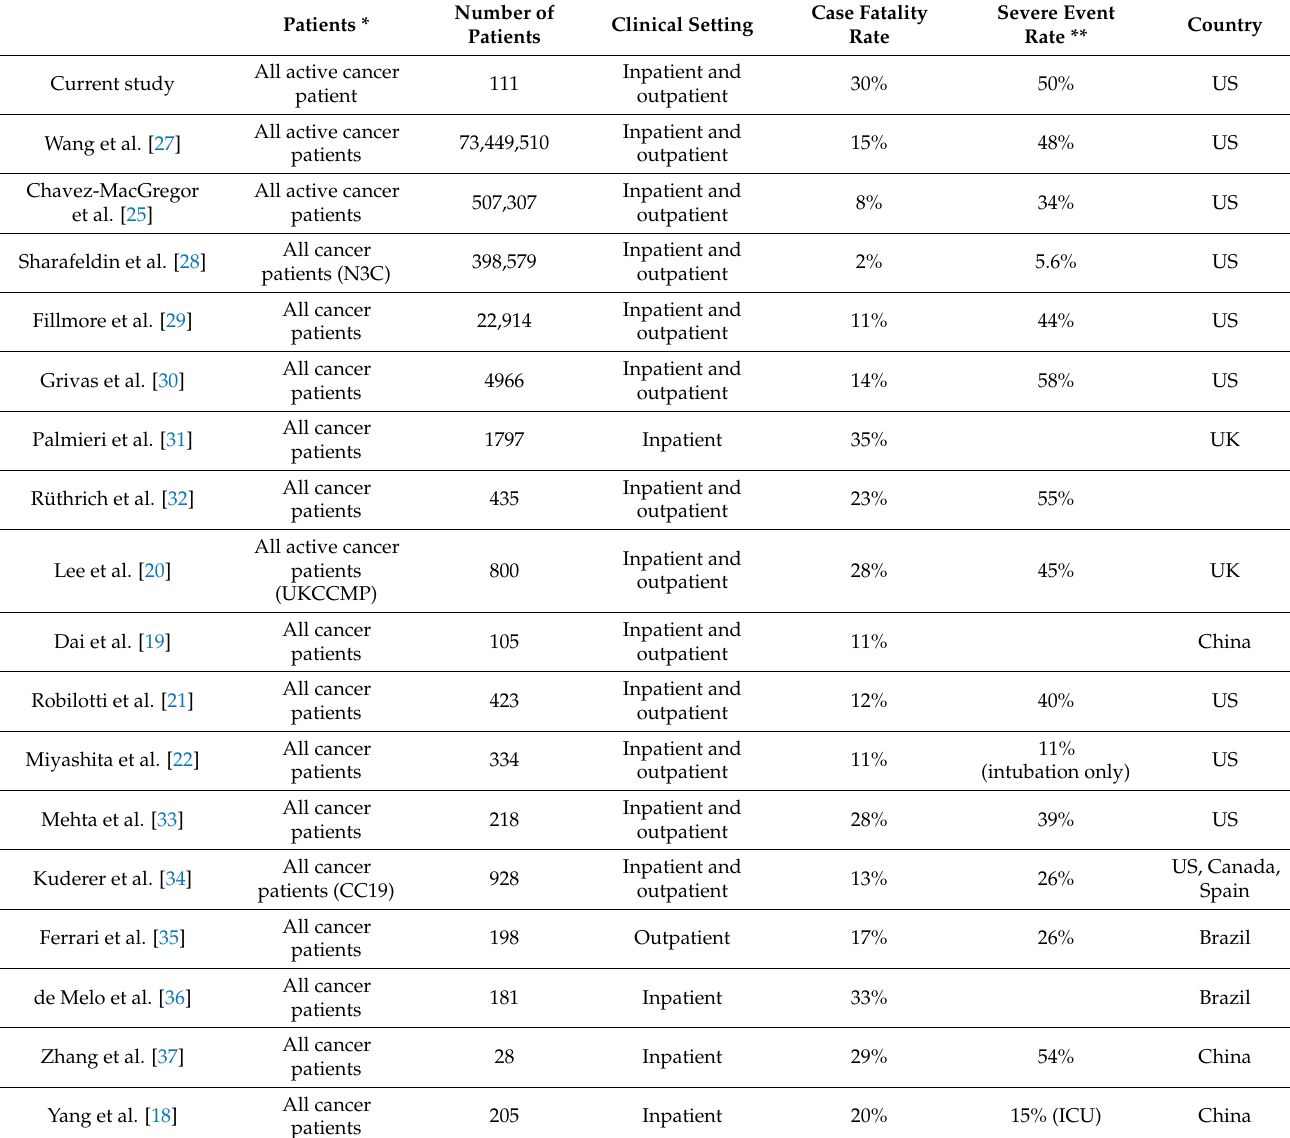
Table 4. Summary of previously reported rates of COVID mortality and